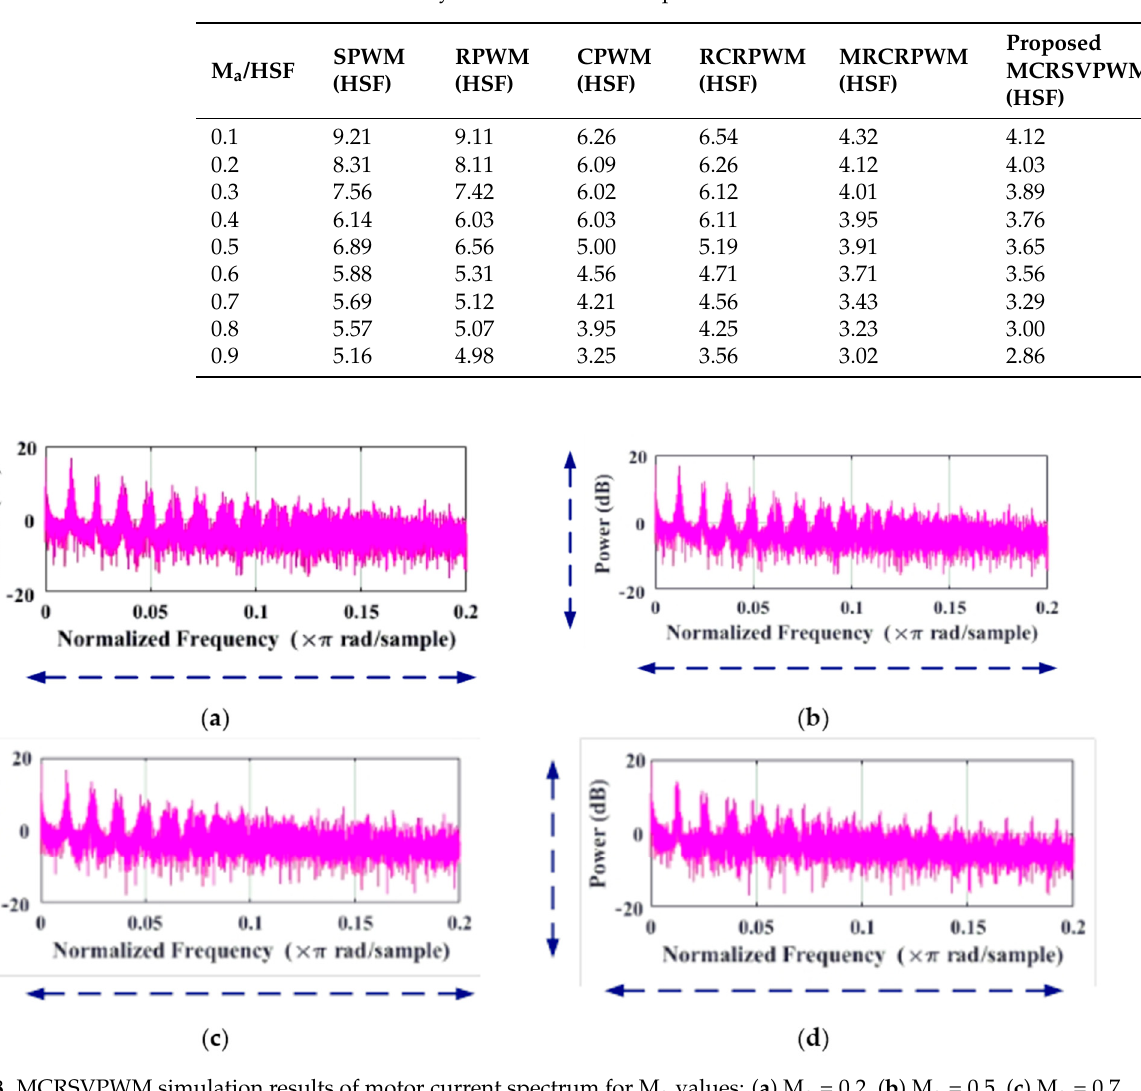
Table 4. Simulation study results comparing the line voltage and line voltage THD for the proposed MCRSVPWM with the other reported RPWM methods.